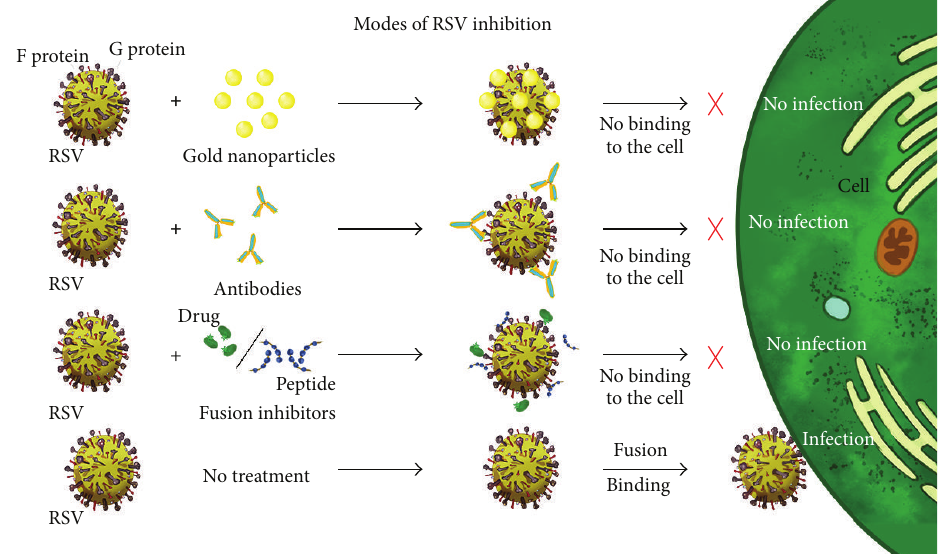
Figure 5: A schematic representation of various compounds inhibiting RSV binding to the cell.